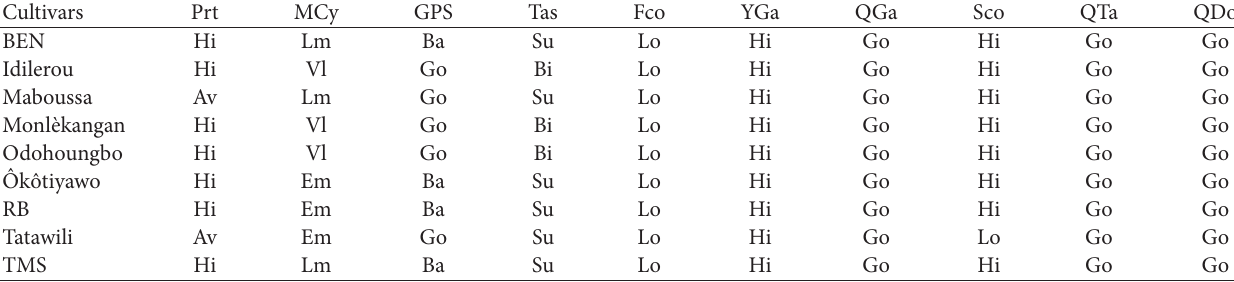
Table 2: Agronomic, culinary, and technology characteristic of elite cultivars.